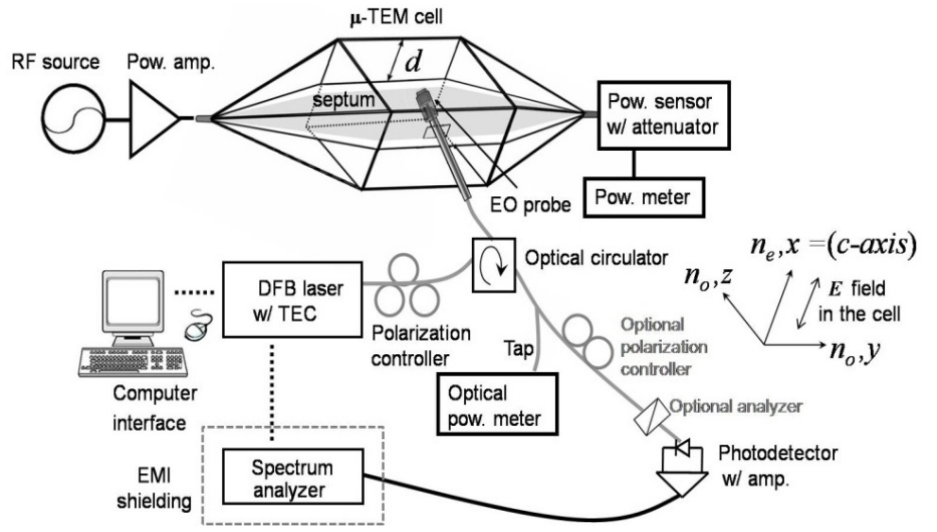
Figure 13. Experimental schematic for an all-fiber-based EO-probe calibration system. (The gray and black lines are optical fibers and electrical connections, respectively).